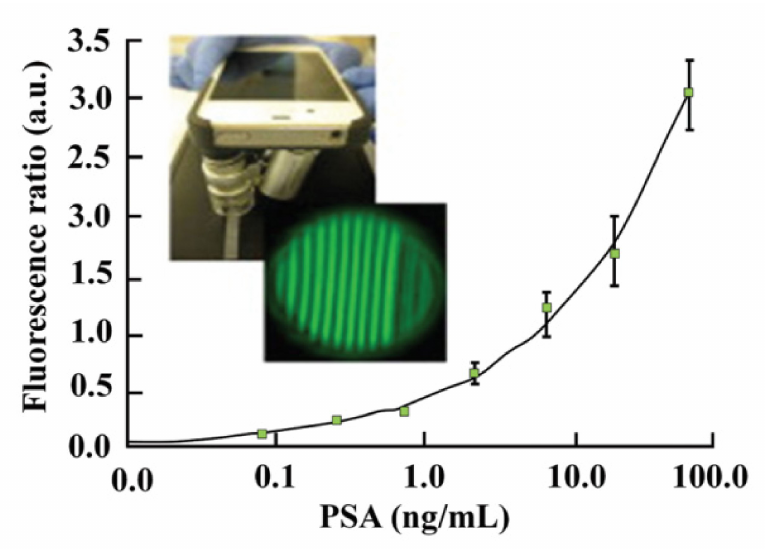
Figure 1. Nimse and co-workers used a portable smartphone-based fluorescence analyser to quan- titively detect the prostate specific antigen (PSA) in the whole blood sample. The higher the PSA concentration is, the more intense the fluorescent signal is that is recorded